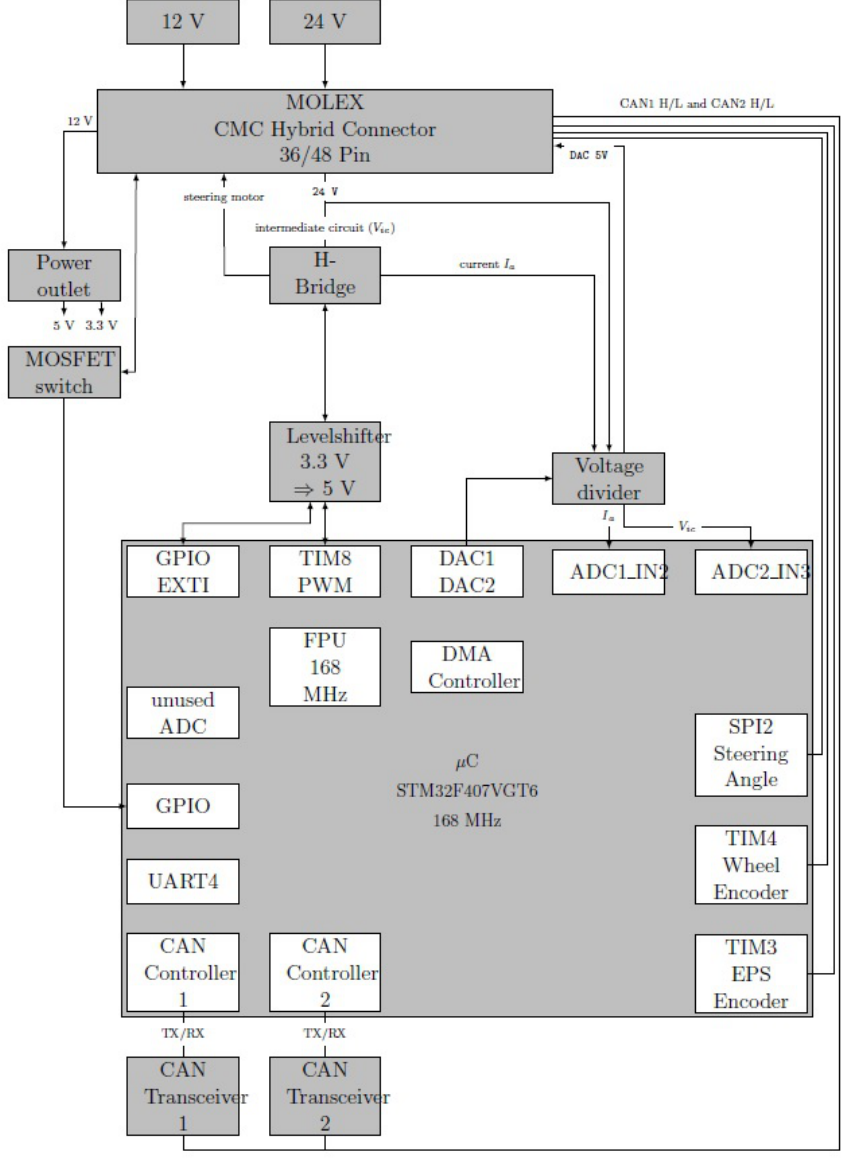
Fig. 4. ECU of the E-Quad